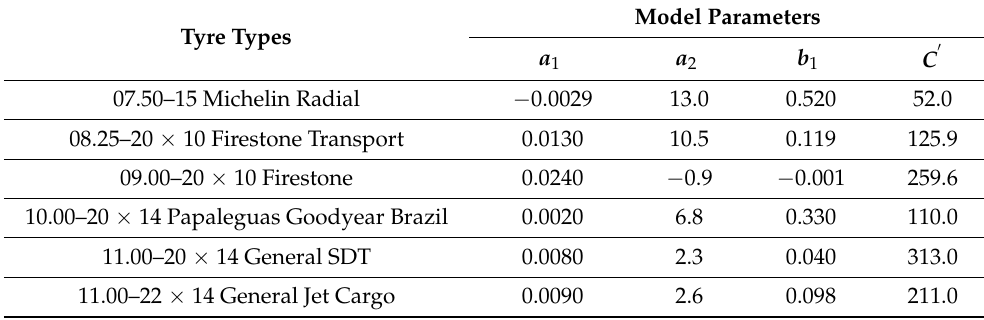
Table 1. Relationship among contact pressure, inflation pressure, and wheel load, according to [11].